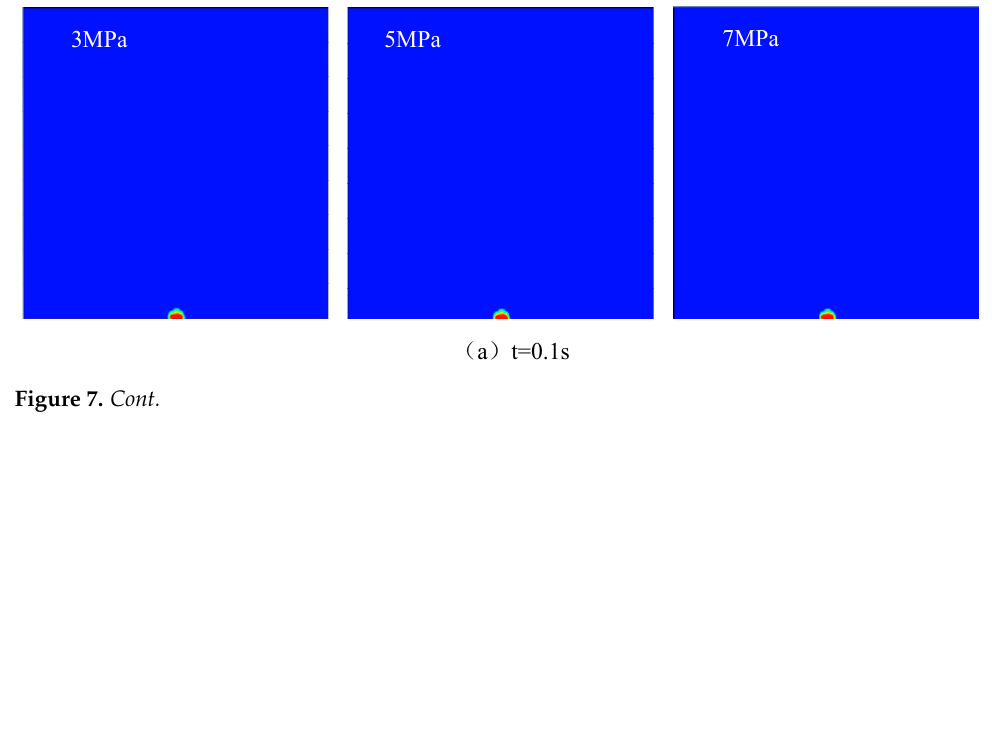
Figure 6. Leakage and diffusion nephogram of submarine natural gas at each time when the leakage aperture is 20 mm, 50 mm and 100 mm respectively.